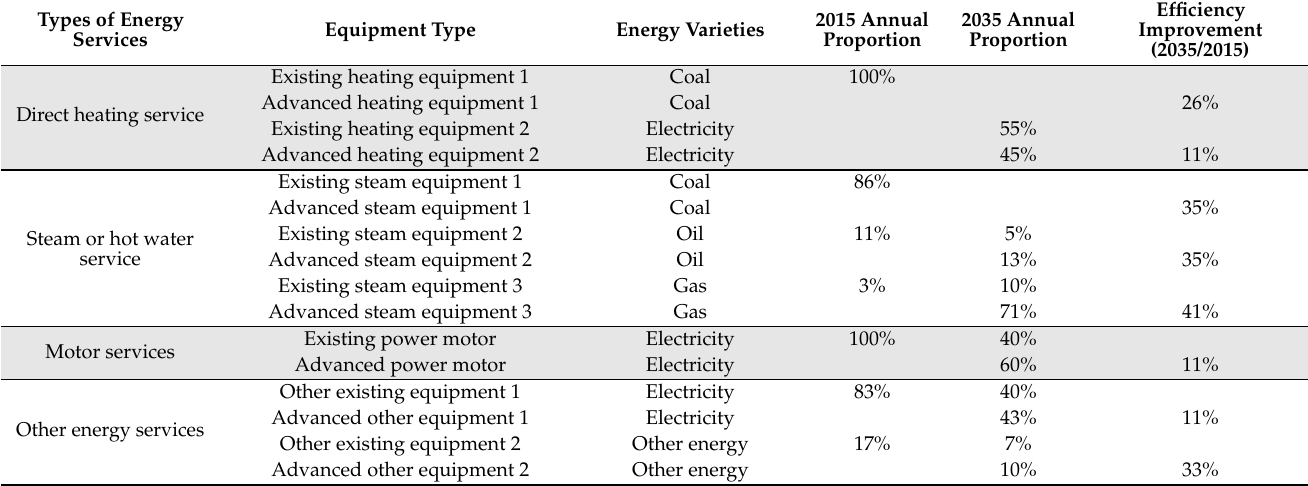
Table A3. Equipment adjustments for the non-metallic mining and processing industries.